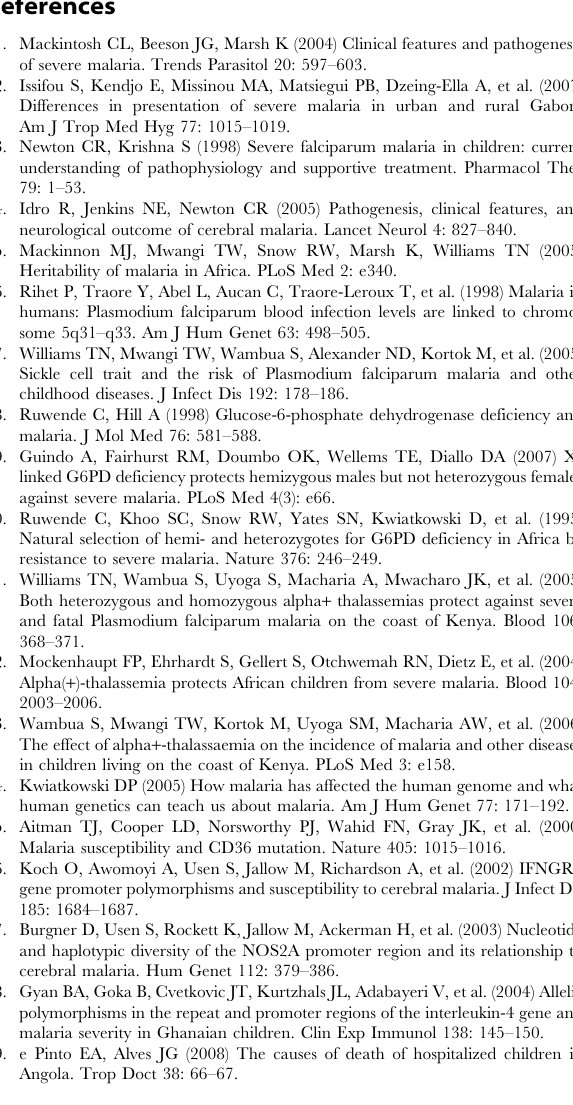
Figure S1 Relative frequency distribution of the HMOX1 repeat alleles in distinct malaria